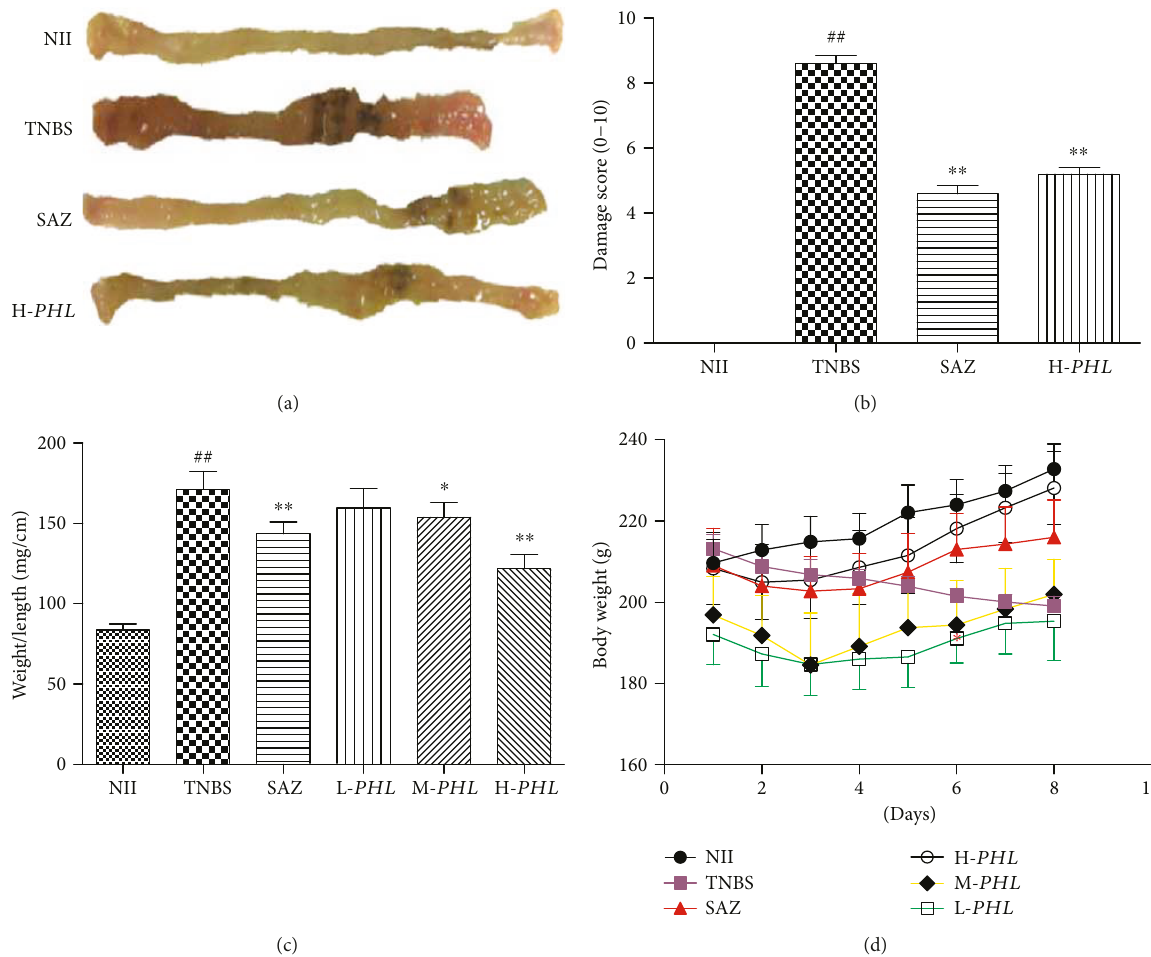
Figure 1: E ff ects of PHL extract on macroscopic images of the colon (a), the macroscopic damage score (b), the weight/length ratio (c), and colonic daily changes in body weight (d) in rats with TNBS experimental intestinal in fl ammation. Data are expressed as means ± SEM ( n = 5 ); ∗∗ P < 0 01 and ∗ P < 0 05 versus TNBS; ## P < 0 01 versus